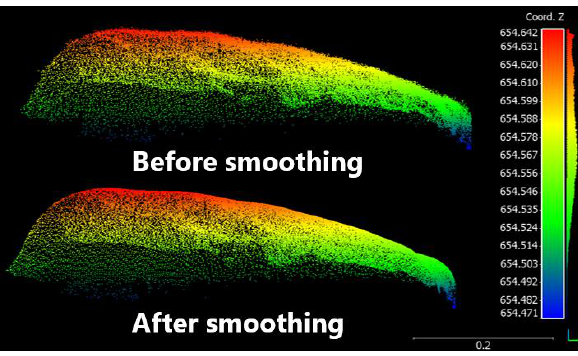
Figure 3. Smoothing